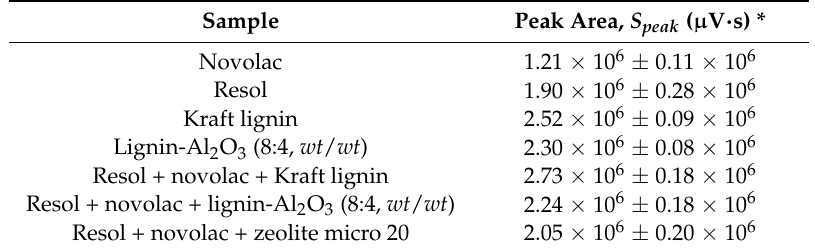
* The sum of seven injections from the same vial ± standard deviation for three repetitions of the whole analysis for three independent vials. Table 8. The value of peak area of the phenol emitted from tested samples during HS